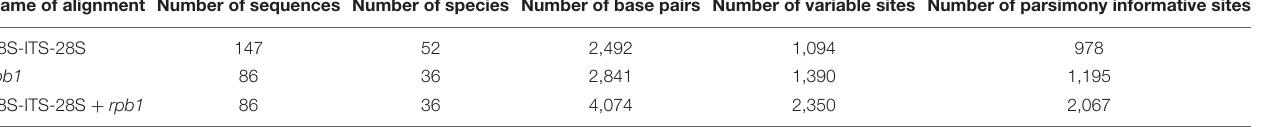
TABLE 2 | Characteristics of the sequence alignments